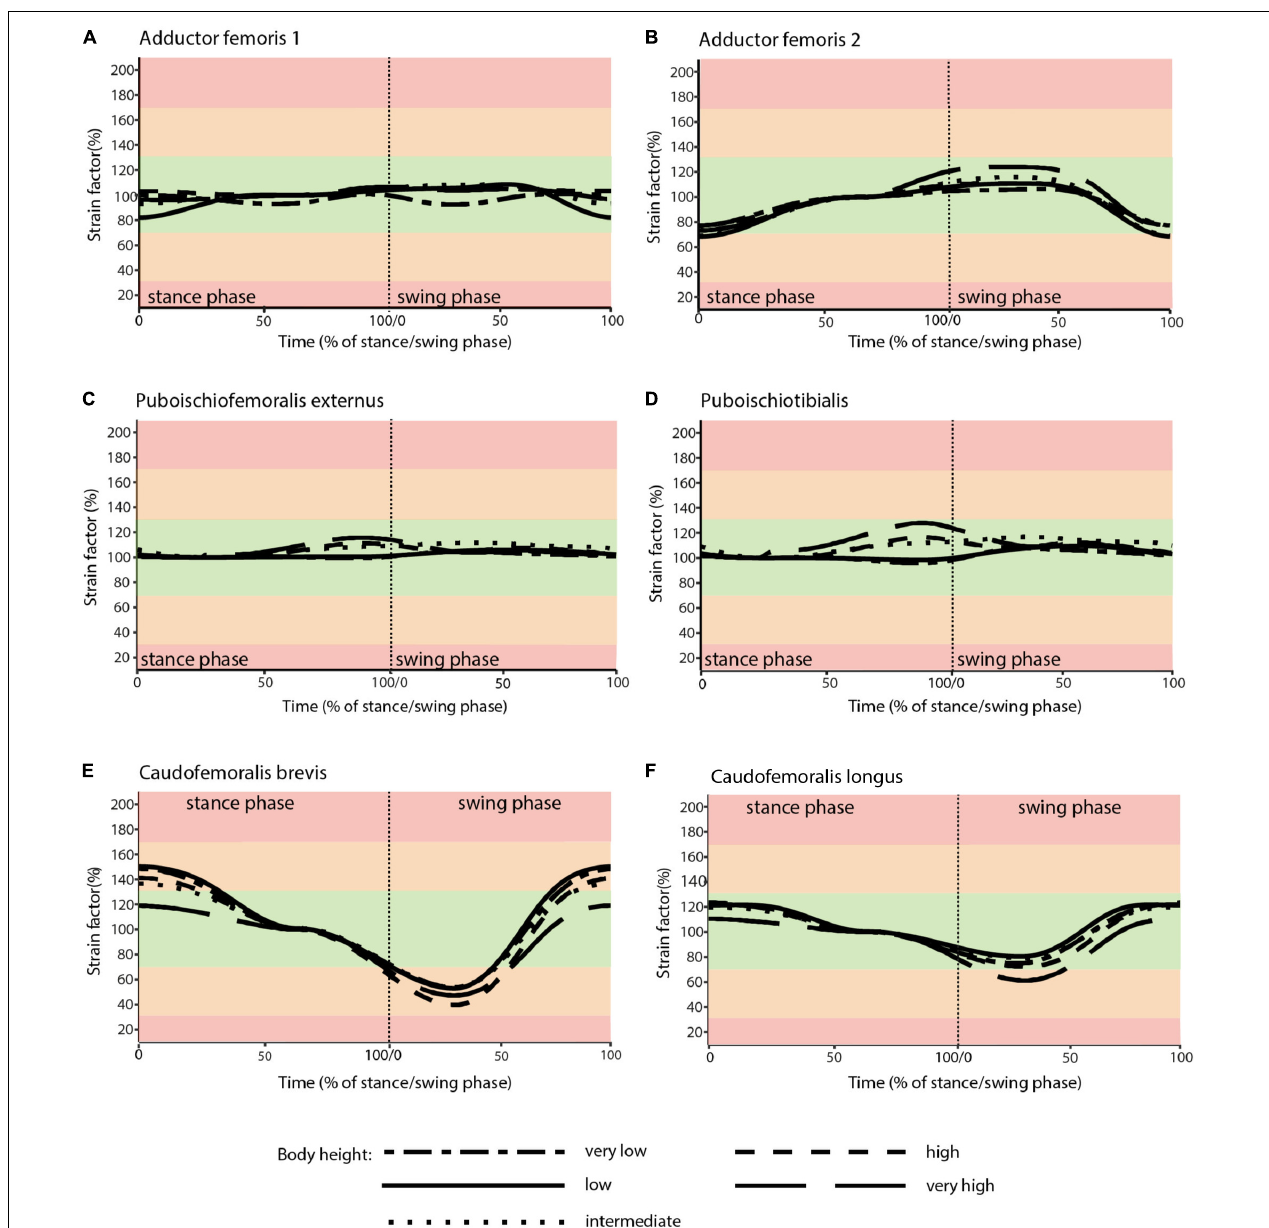
FIGURE 8 | Muscle strains plotted against percentage of stance and swing phase in Orobates for each of the five analyzed body heights. (A) ADD1; (B) ADD2; (C) PIFE; (D) PIT; (E) CFB; (F) CFL. Red areas of the plots involve muscle tension beyond 170% or compression below 30% of resting length and is considered implausible in this study. Green areas of the plots represented optimal muscle length for the generation of force (between 70 and 130% of reference length). Orange areas represent feasible muscle strains with limited potential for force